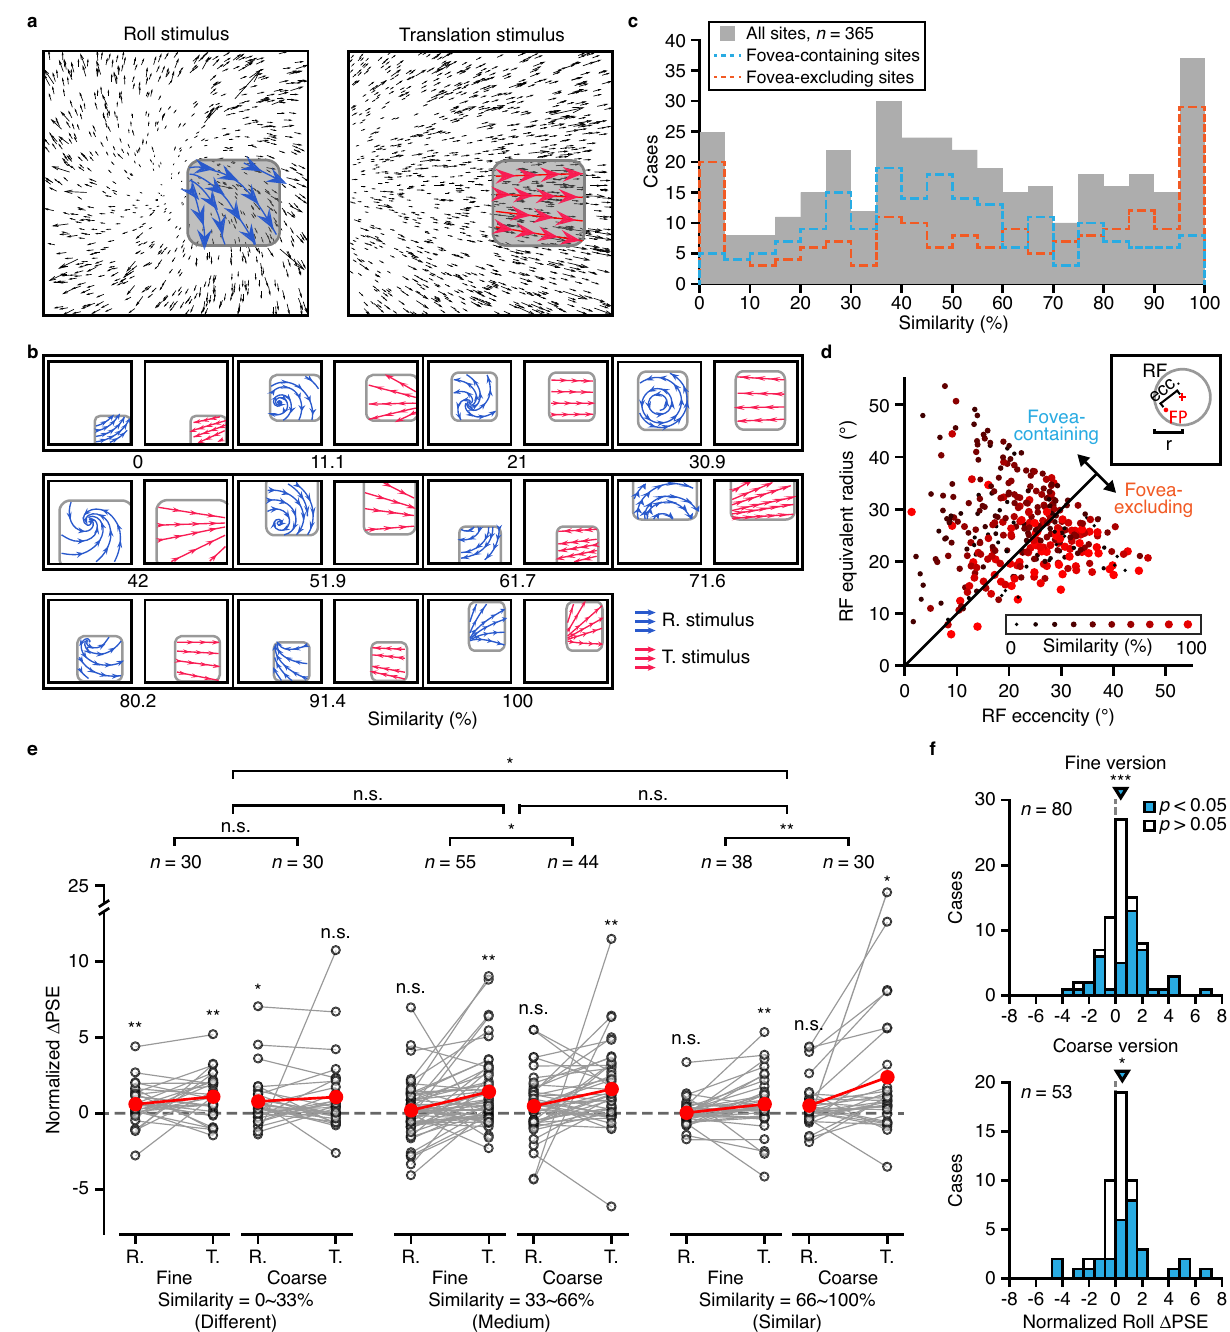
Fig. 8 | Similarity of preferred optic fl ow pattern within the receptive fi eld. a The preferred optic fl ow pattern in roll-rotation plane and translation plane for thesameexamplesiteasin Fig.2a.Graysquare,thereceptive fi eldof theMU.Blue and red quivers, the vector fl ows in RF for roll-rotation stimuli and translation stimuli,respectively.Similarityofpreferredoptic fl owpatternforthisMUis37.0%. b Moreexamplesofpreferredoptic fl owpatterninRFfordifferentsimilarityindex. c Continuous distribution of similarity ranging from 0% (different) to 100% (simi- lar). Gray bar, all data; Blue line, sites with RF containing the fovea; Orange line, sites with RF without covering fovea. d Relationship between similarity and RF properties.Similarity(colorandsizeofdot)isplottedasafunctionofRFequivalent radius and eccentricity. e Normalized microstimulation-induced PSE shift under roll and translation task across three groups of similarity. Open dots, Δ PSE for individual site; Red dots, median of Δ PSE. Asterisk above dots, median Δ PSE sig- ni fi cantlydifferent from zero(n.s.notsigni fi cant; * p <0.05; ** p <0.01,